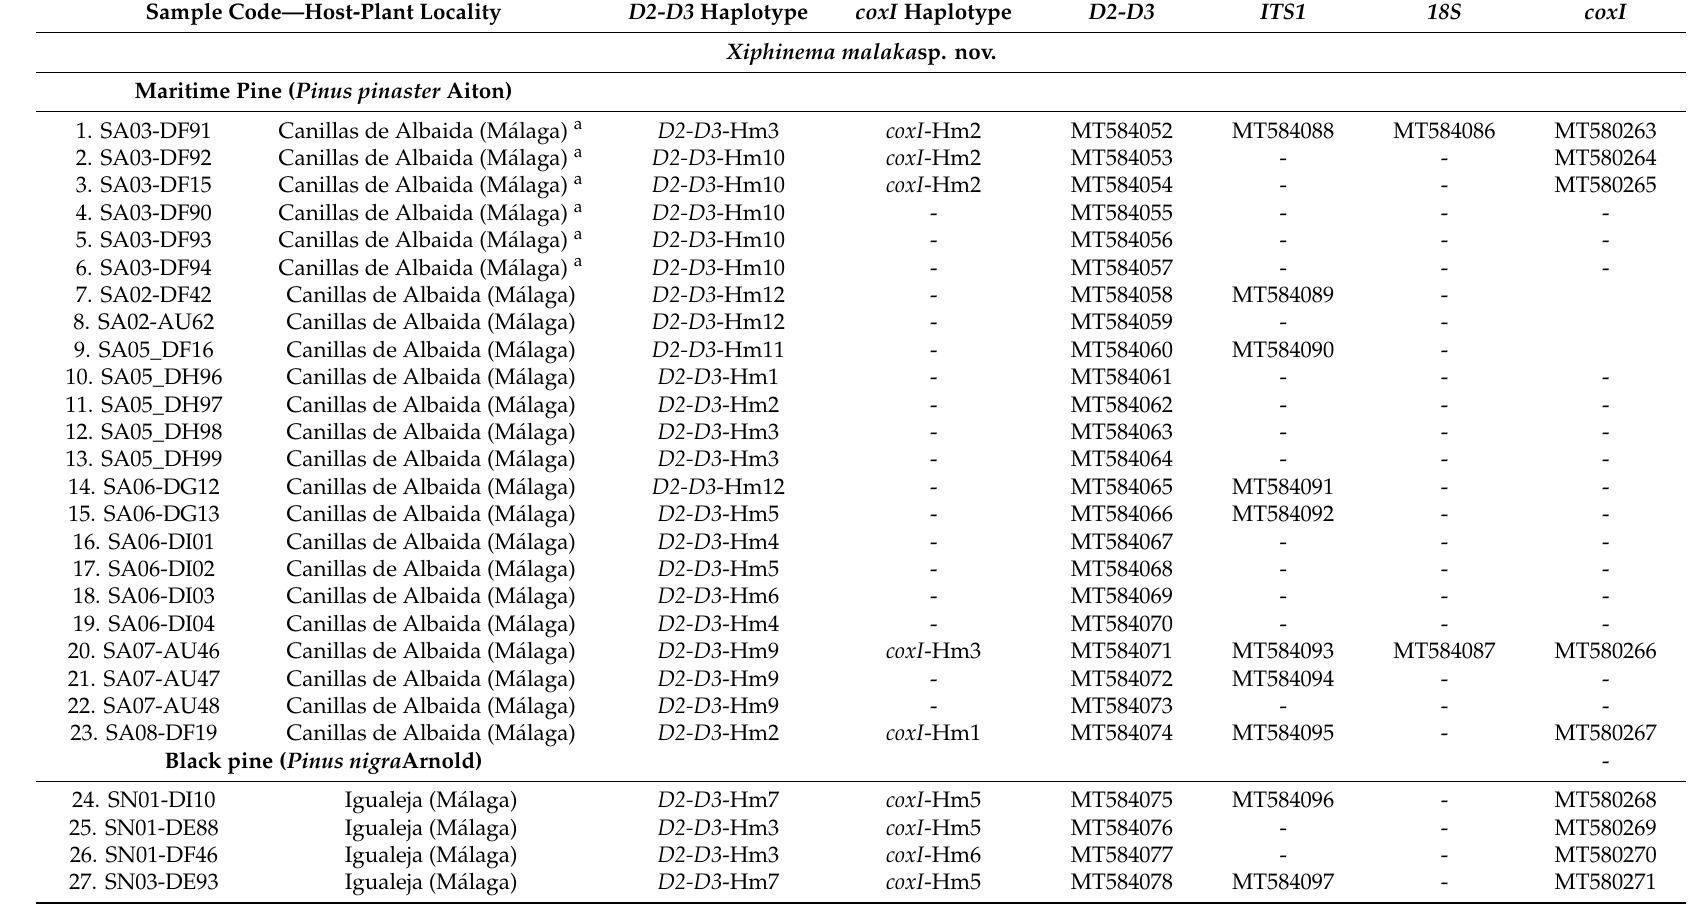
Table 1. Isolates sampled for Xiphinema malaka sp. nov. from several localities of M á laga and Almer í a provinces (Southern Spain), and Xiphinema adenohystherum sequences used in this